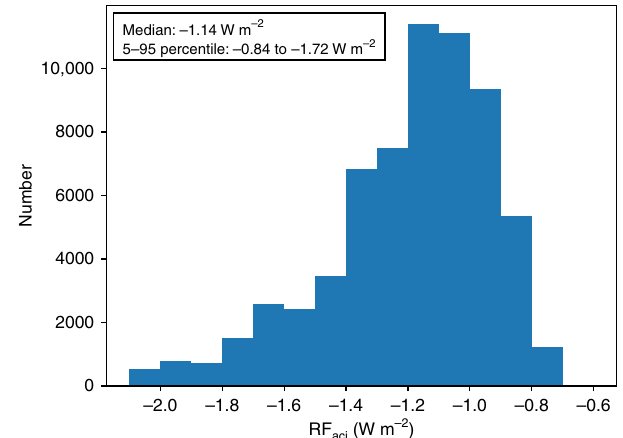
. Histogram of the Radiative Forcing due to Fig. 6 Histogram of RF aci aerosol-cloud interactions (RF ) based on the different values of RF aci aci ; ocean from the different model estimates for the increase in cloud condensation nuclei (CCN) column number between present day (PD) and pre-industrial (PI) times, the different model values of the ratio RF /RF , and the aci aci ; ocean effect of the uncertainty distribution of the susceptibility S opt derived in ccn this